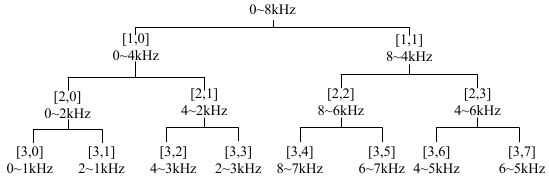
Fig. 1 Three layer wavelet packet